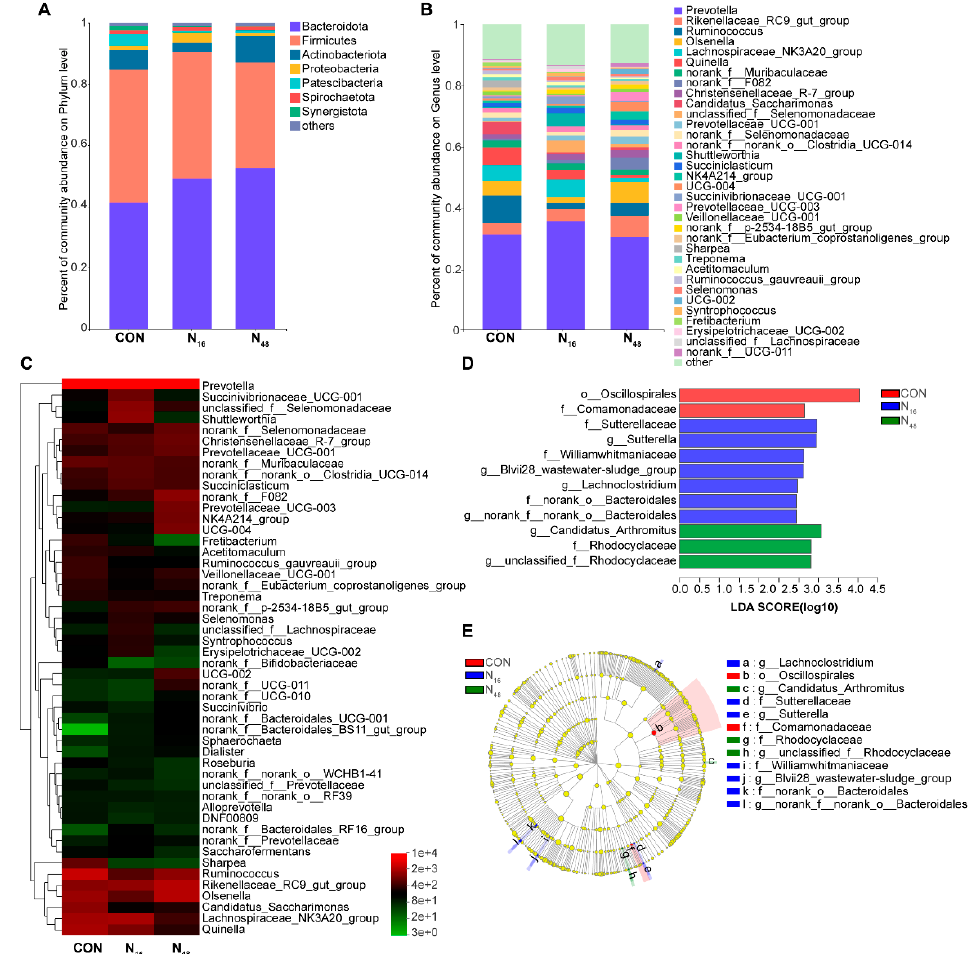
Figure 2. Effects of the fruit of Nitraria tangutorum (FNT) supplement on bacterial species composition and differential species in the rumen in Hu rams. ( A ) Changes in bacterial composition at the phylum level; ( B ) changes in bacterial composition at the genus level; ( C ) hierarchical cluster analysis of the relative abundances of rumen bacteria at the genus level; ( D ) analysis of the differential species, based on LEfSe; (E) Branch diagram of microbial evolution.